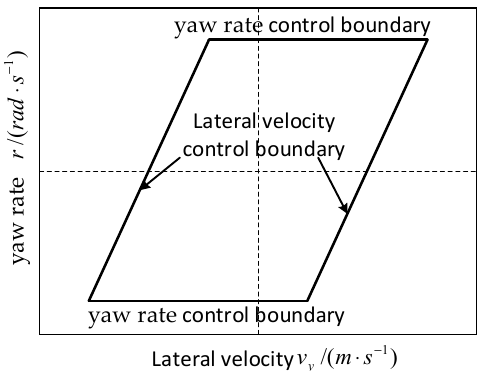
Figure 5. Schematics of envelope constraint of vehicle swing.